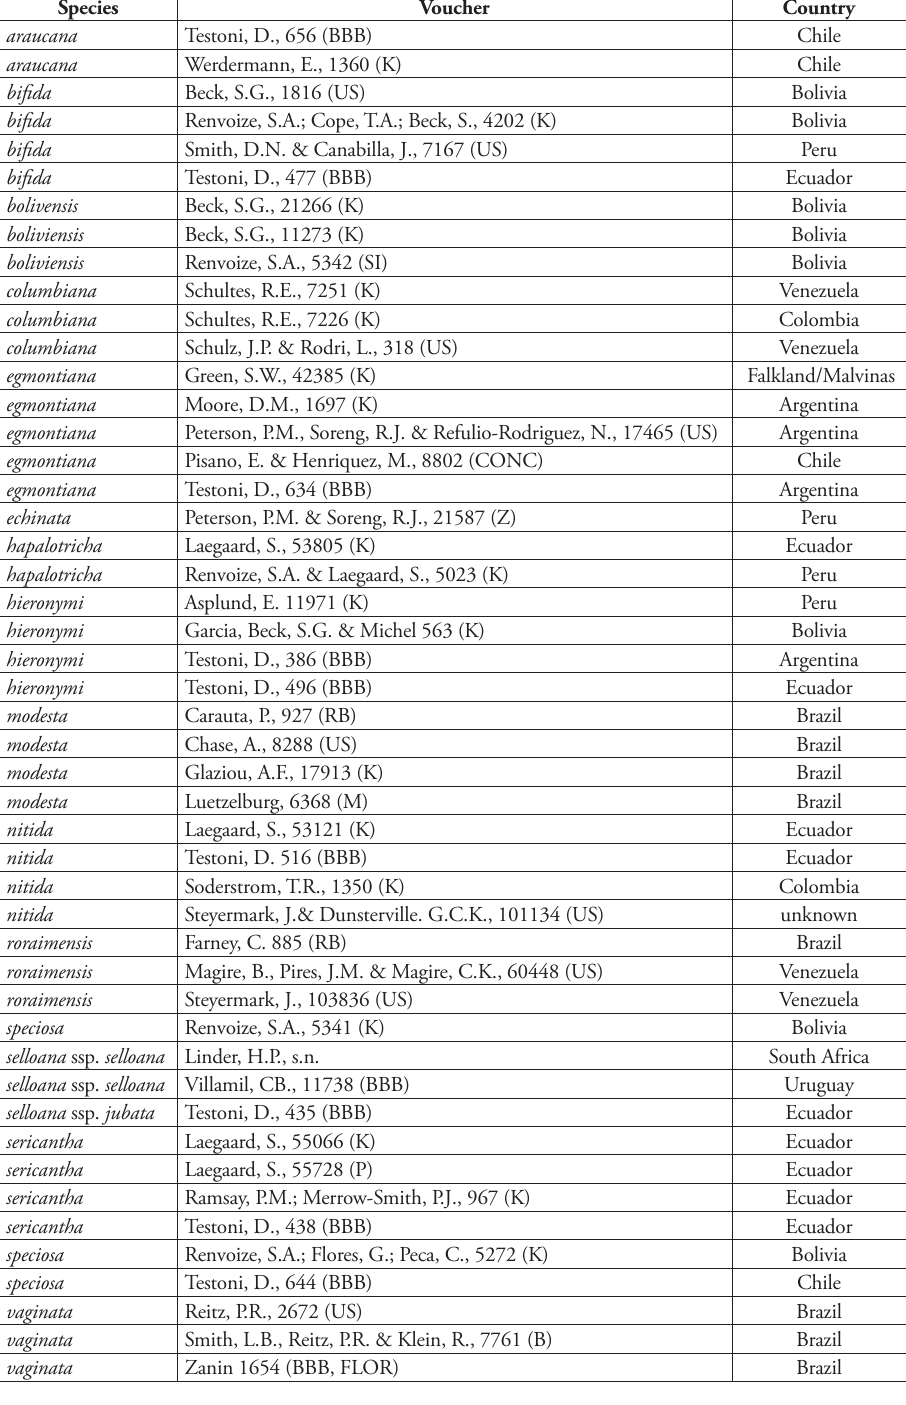
Table 1. Vouchers for